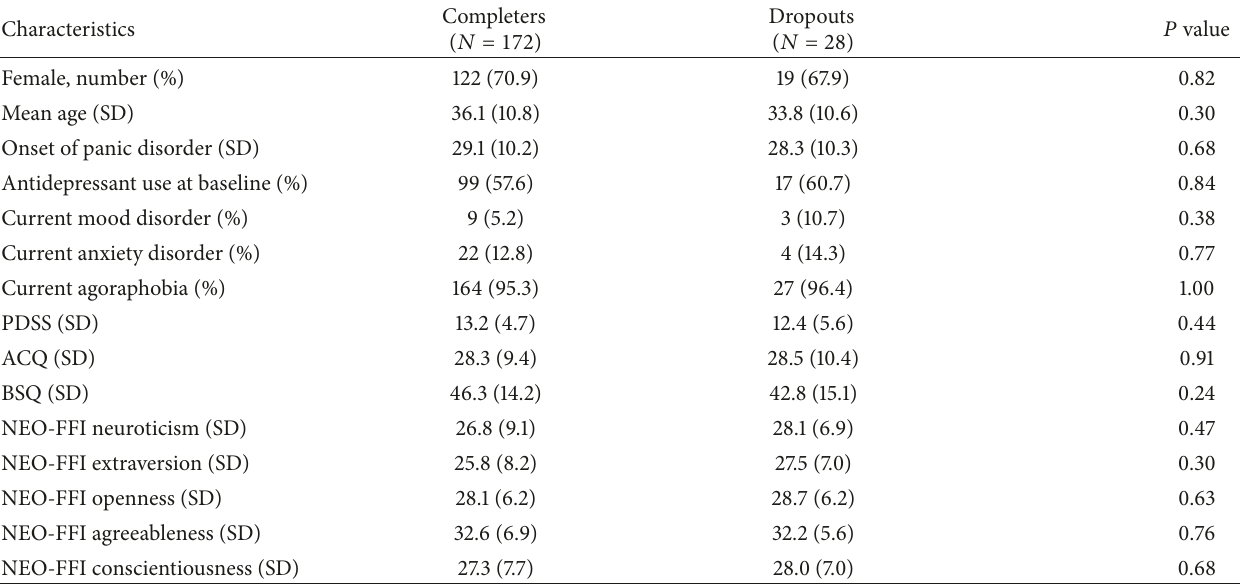
Table 1: Baseline characteristics of the